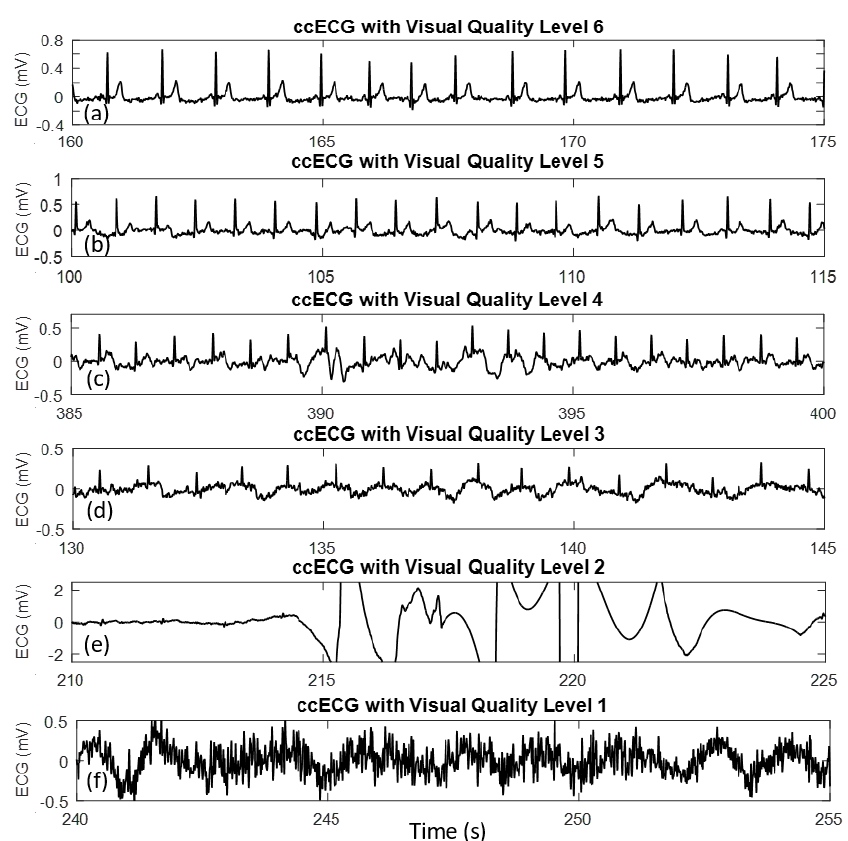
Figure 2. Example of ccECG signals acquired from mattress setup with different visually identified quality levels VQ. In ( a ) signal with VQ Level 6; in ( b ) signal with VQ Level 5; in ( c ) signal with VQ Level 4; in ( d ) signal with VQ Level 3; in ( e ) signal with VQ Level 2; in ( f ) signal with VQ Level 1.